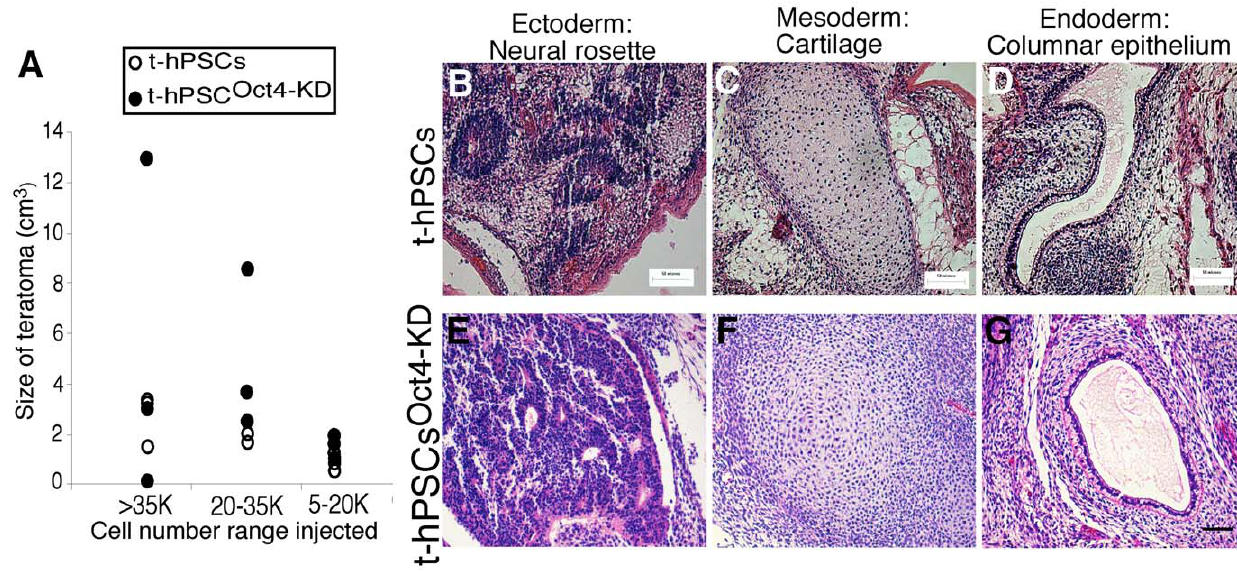
Figure 2. Downregulation of Oct4 has no effect on t-hPSC pluripotency or tumor-initiating cell capacity. (A) Summary of teratoma formation from control and Oct4 knockdown t-hPSCs at serial injected cell doses. Cell doses of 7.5 6 10 3 , 2.4 6 10 4 , and 6.6 6 10 4 t-hPSCs and 1.5 6 10 4 , 3.3 6 10 4 and 6.6 6 10 4 Oct4 knockdown t-hPSCs were injected into the testis capsules of NOD/SCID mice. Mice were sacrificed 6 weeks after injection. Teratoma size was measured and plotted relative to injected cell doses. N=7. (B–G) Representative histology of teratomas formed in NOD/SCID mice testes 6 weeks following injection of control t-hPSCs (B–D, upper panel) or Oct4 knockdown t-hPSCs (E–G, bottom panel). Tissues representing all three embryonic germ layers including ectoderm (neural rosettes, B and E, left panels), mesoderm (cartilage, C and F, middle panels), and endoderm (columnar epithelium, D and G, right panels) are shown. Scale bar=50 m m.